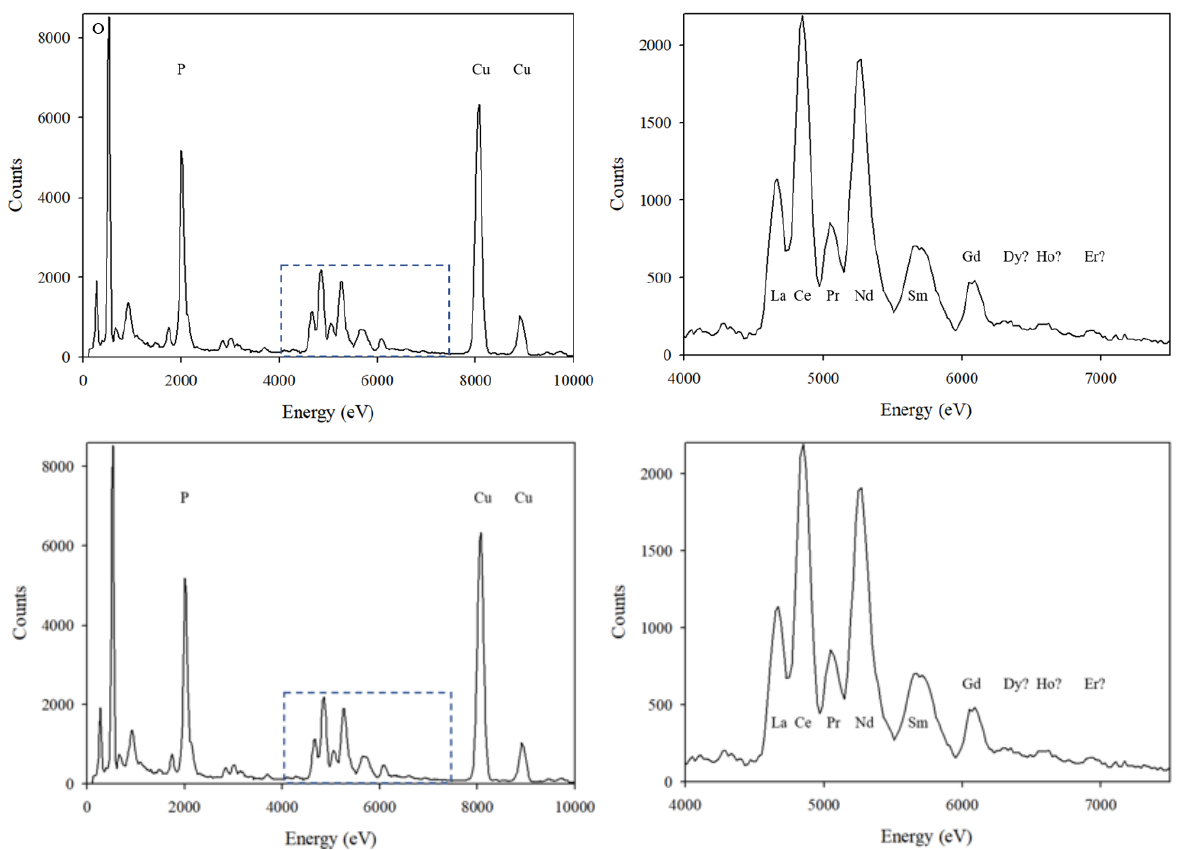
and Y element map.